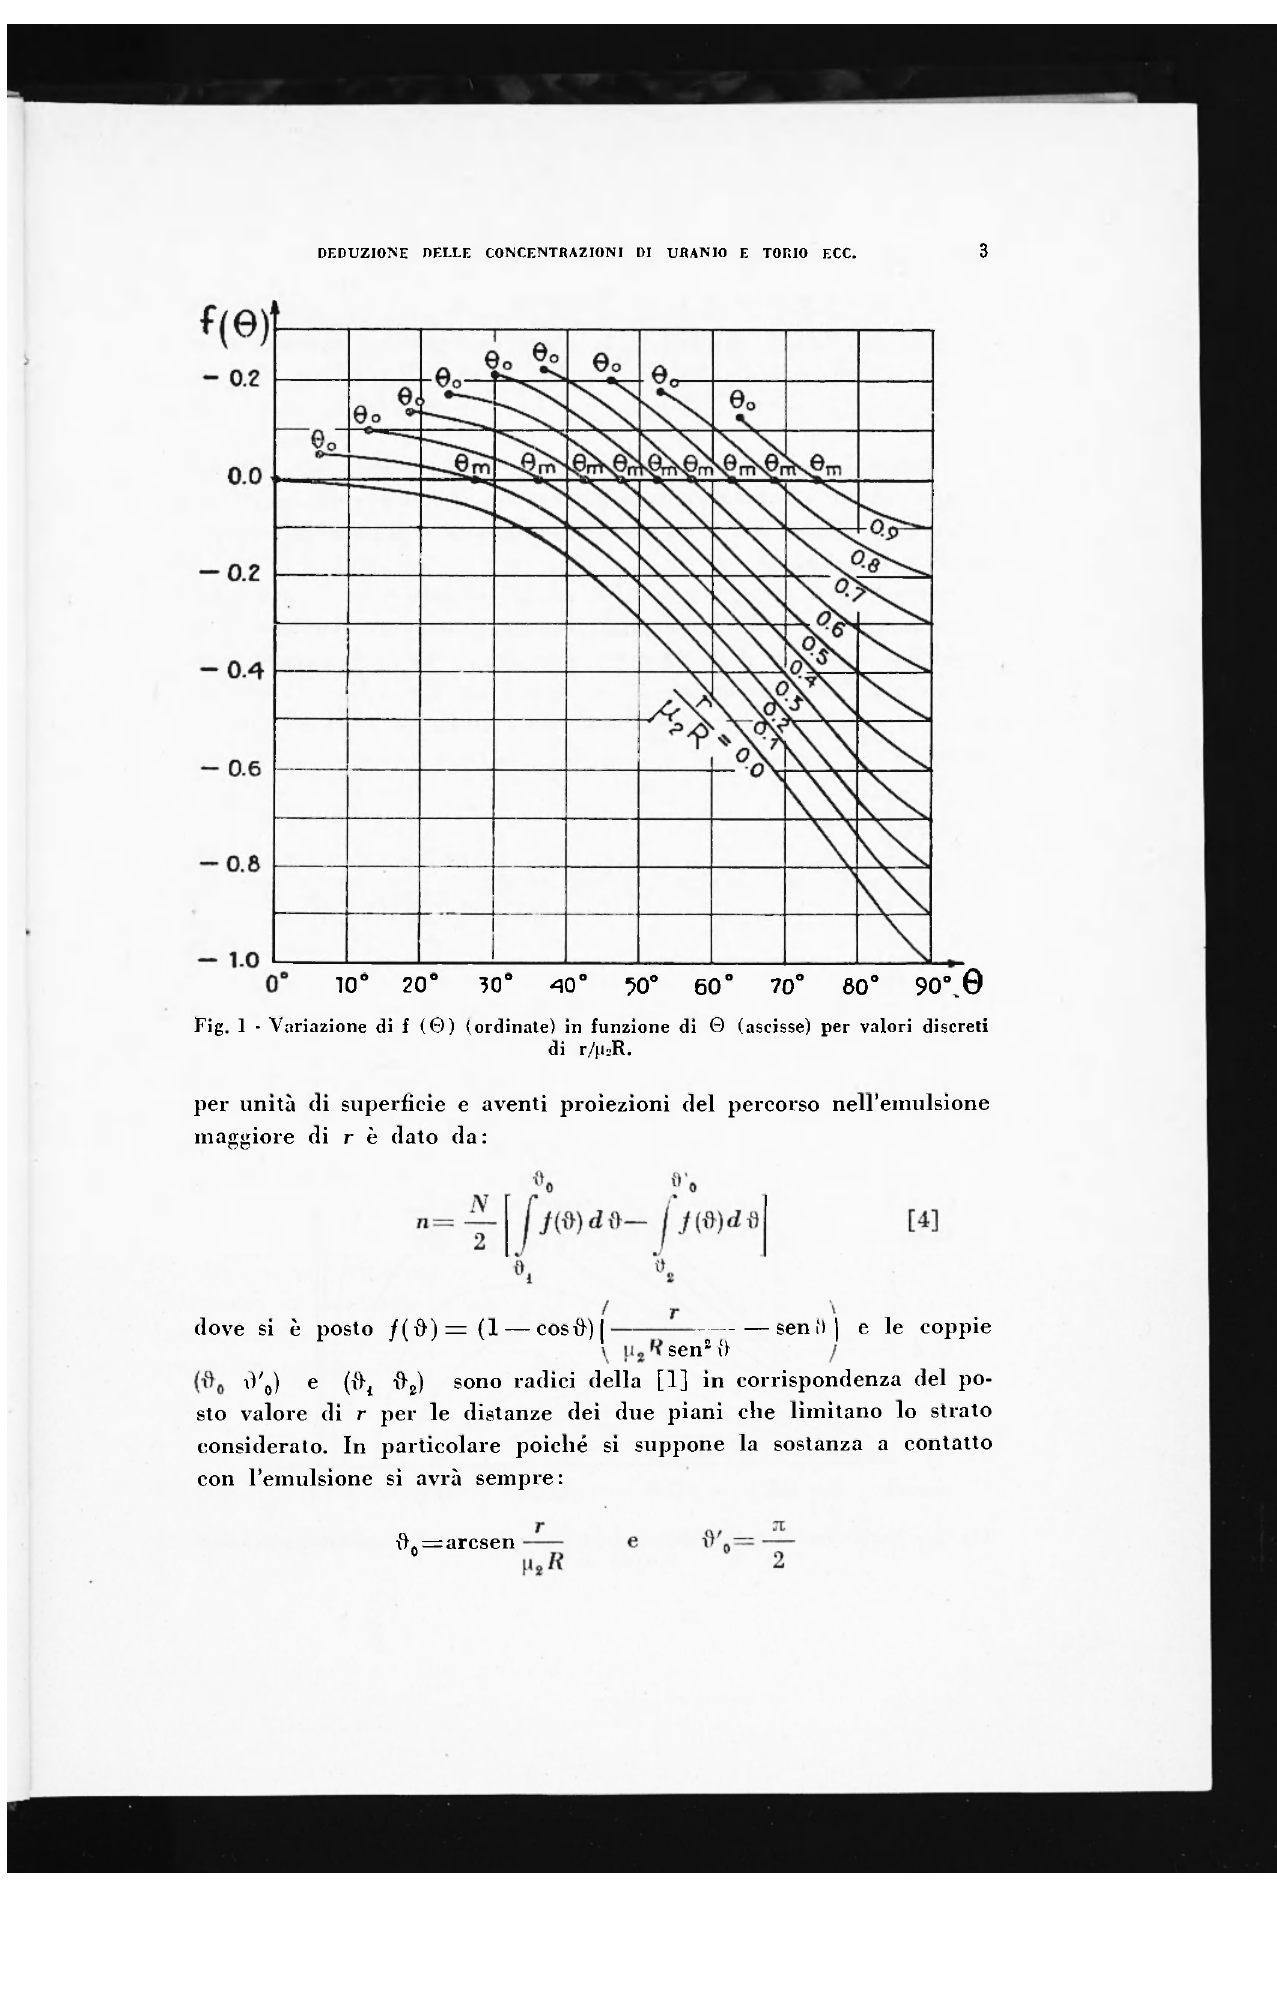
Fig. 1 - Variazione di f ( 0) (ordinate) in funzione di 0 (ascisse) per valori discreti di r/ftsR. per unità di superficie e aventi proiezioni del percorso nell'emulsione maggiore di r è dato